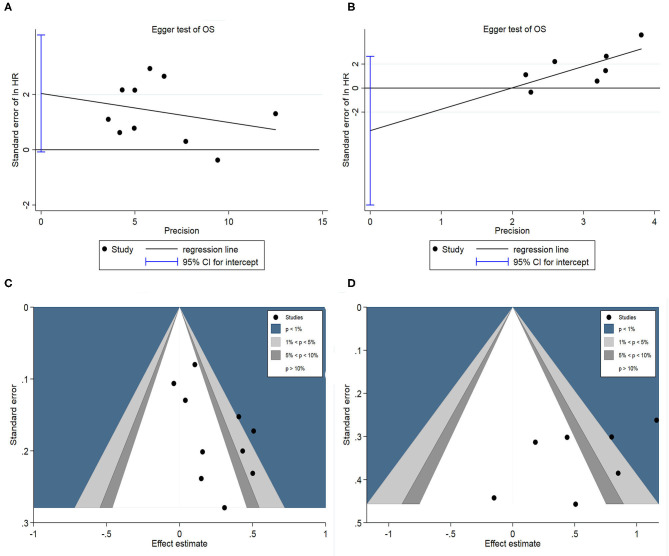
(A) Egger's funnel plot of HAIC as palliative treatment for OS; (B) Egger's funnel plot of HAIC as adjuvant treatment for OS; (C) Contour-enhanced funnel plot for HAIC as palliative treatment; (D) Contour-enhanced funnel plot for HAIC as adjuvant treatment.